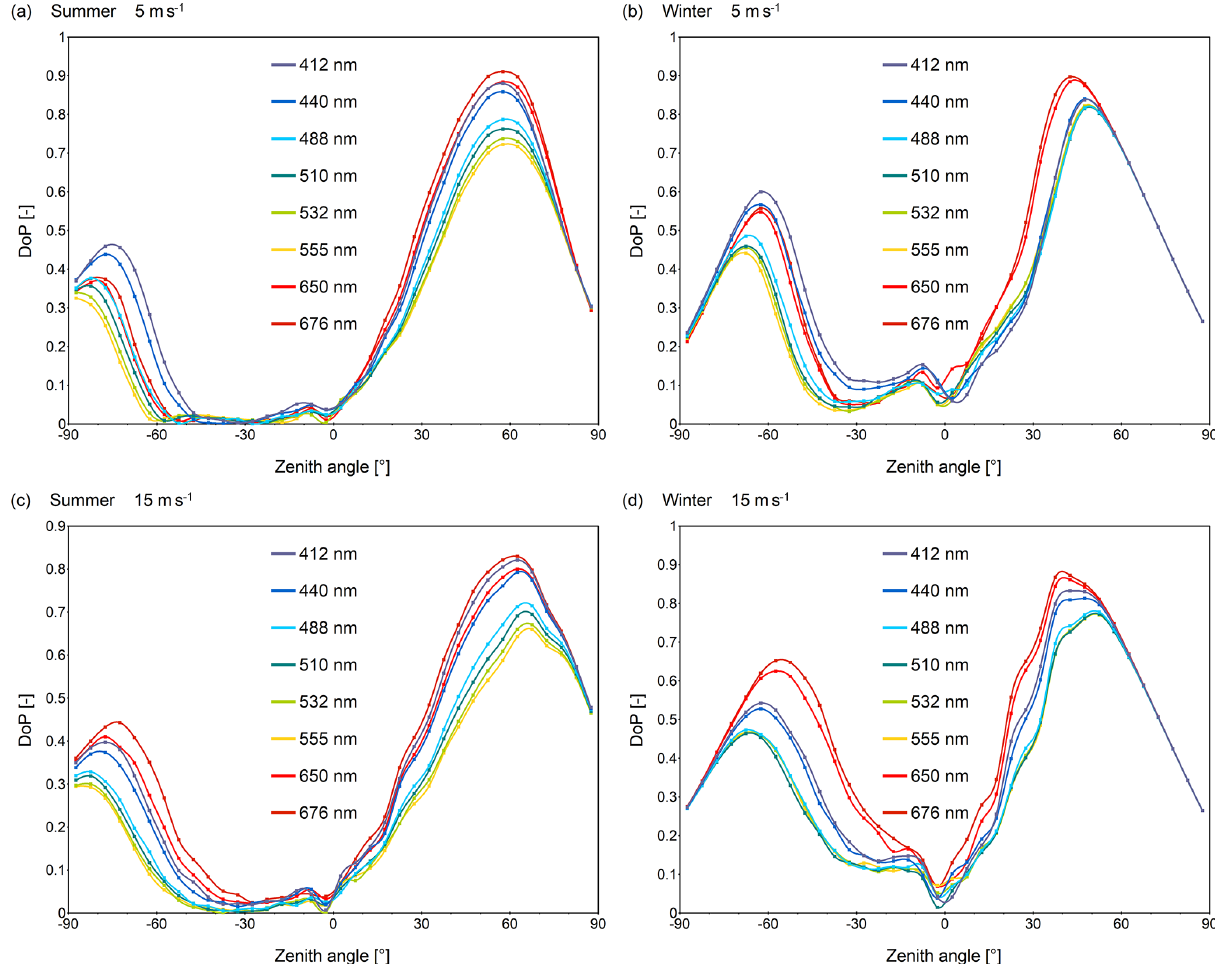
Figure 5. Degree of polarization plotted for the principal plane, e.g., plane containing both the incident ray of the Sun and zenith direction (cross-section through polar plots for azimuths 0 and 180 ◦ ). Azimuth of 0 ◦ is the azimuth of Sun position is marked by negative zenith angles, while azimuth 180 ◦ , which contains the Sun reflection, is marked by positive zenith angles. Simulation results for open Baltic Sea water: (a) summer season, SZA 45 ◦ , wind speed 5ms − 1 , (b) winter season, SZA 75 ◦ , wind speed 5ms − 1 , (c) summer season, SZA 45 ◦